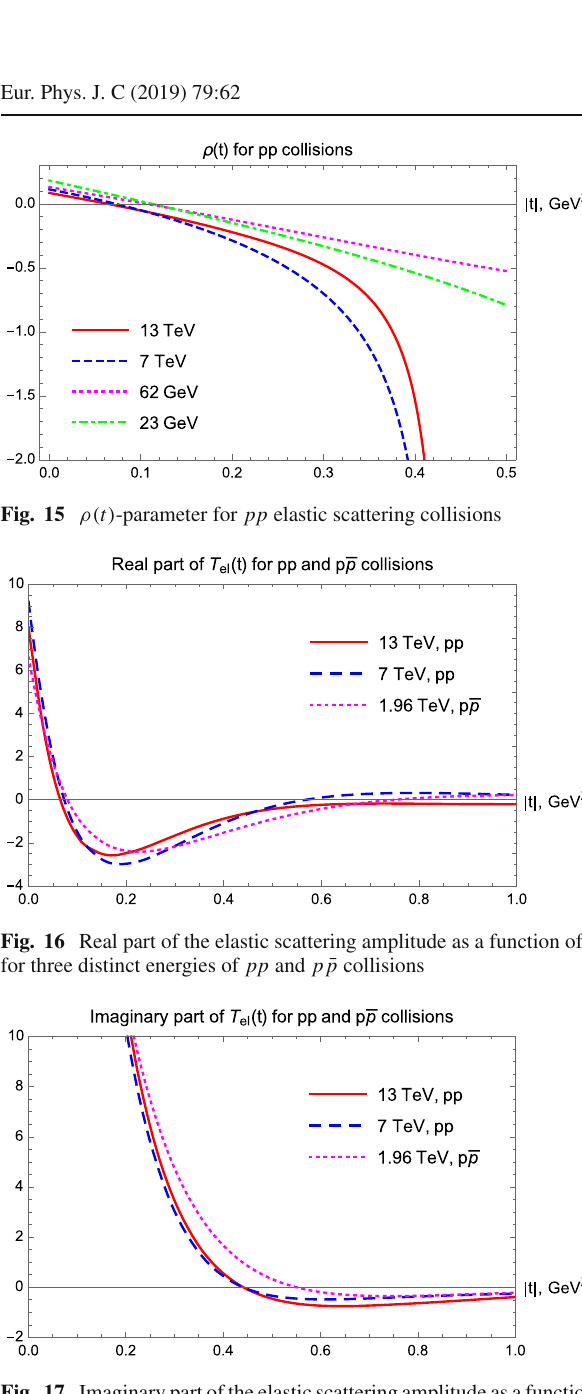
Fig. 17 Imaginary part of the elastic scattering amplitude as a function of t for three distinct energies of pp and p ¯ p collisions